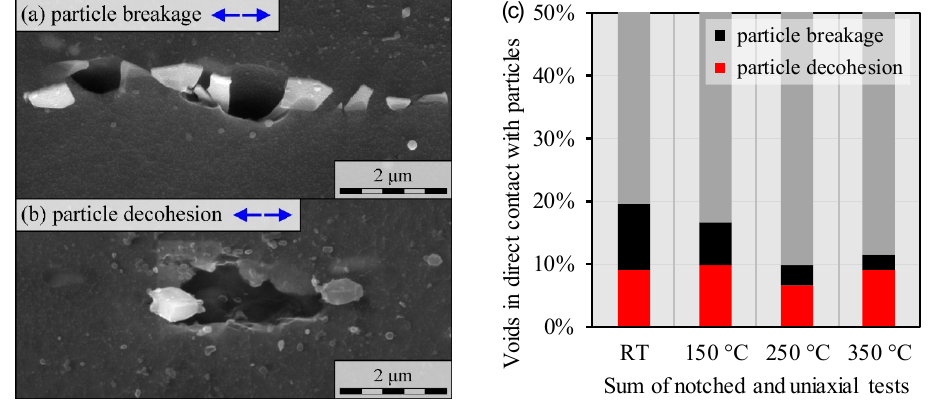
Figure 10. SEM images of a particle breakage ( a ) and the decohesion of a particle from the matrix ( b ), which led to void nucleation in the notched specimen at 200 °C; Statistics on the analyzed voids that were in direct contact with particles after the test ( c ).